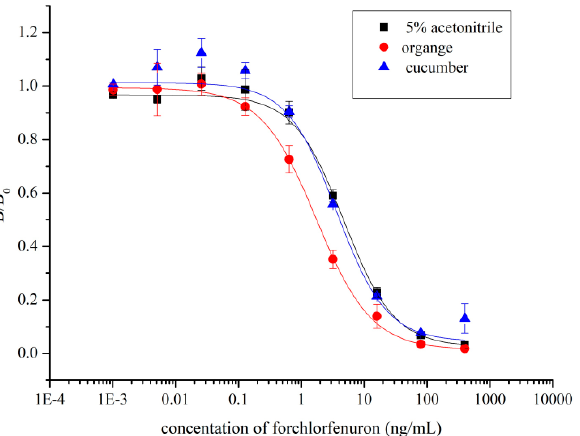
Figure 5. Matrix effects of cucumber and orange samples (n = 3). Standard curves were fitted using PBS containing 5% acetonitrile, spiked orange matrix (diluted with PBS containing 5% acetonitrile to twenty-fold), and spiked cucumber matrix (diluted with PBS containing 5% acetonitrile to twenty-fold). The three curves nearly overlap . Table 3. Recoveries of CPPU-spiked food samples determined by icELISA (n = 3).